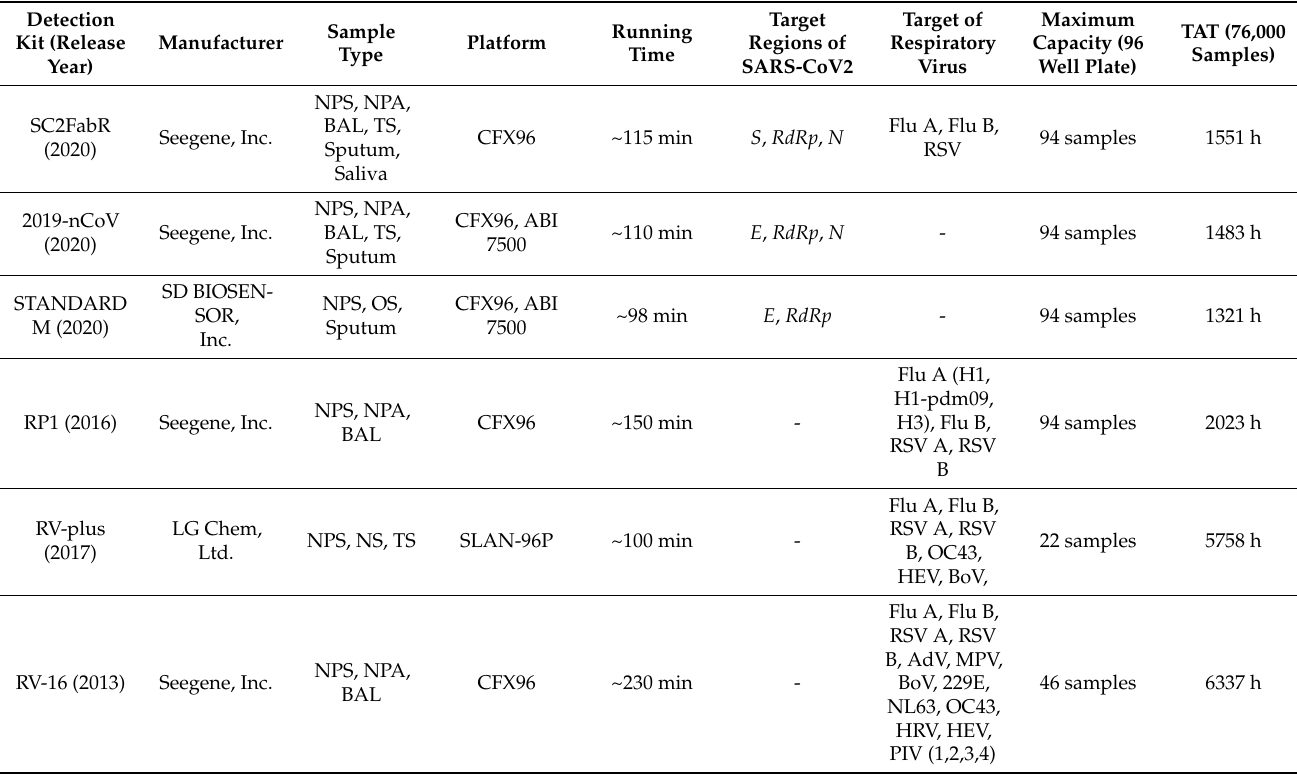
Table 1. Overview of molecular in vitro diagnostic multiplex PCR assays used in this